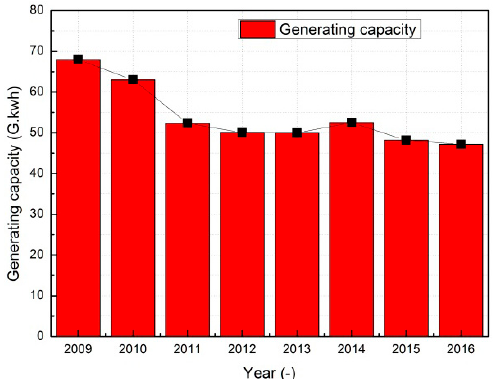
Figure 1. Generating capacity in a peaking power plant by year.